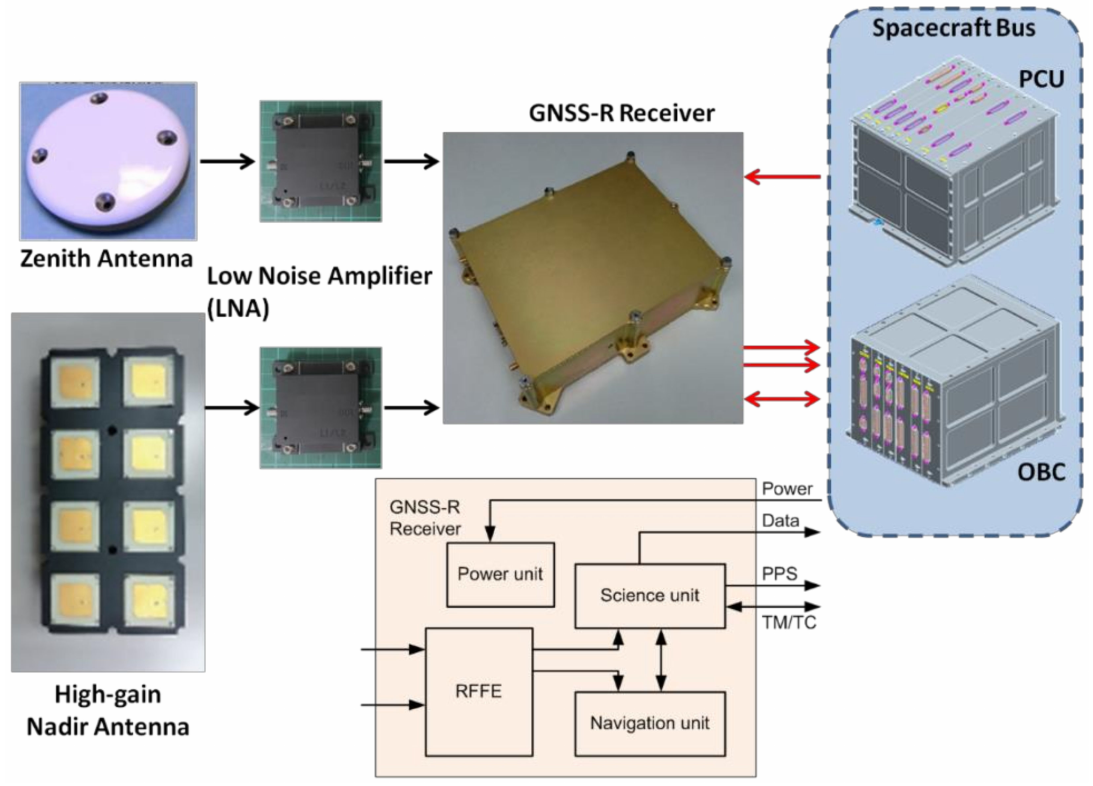
Figure 8. The GNSS-R payload